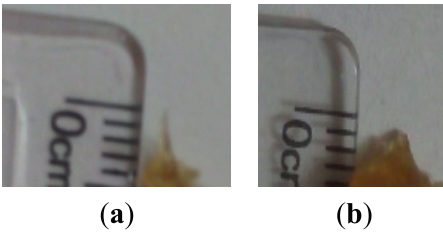
Figure 9. Microneedles formed using micromolding at 70 °C for ( a ) Fish scale biopolymer ( b ) Fish scale biopolymer with 20 g nanocellulose.